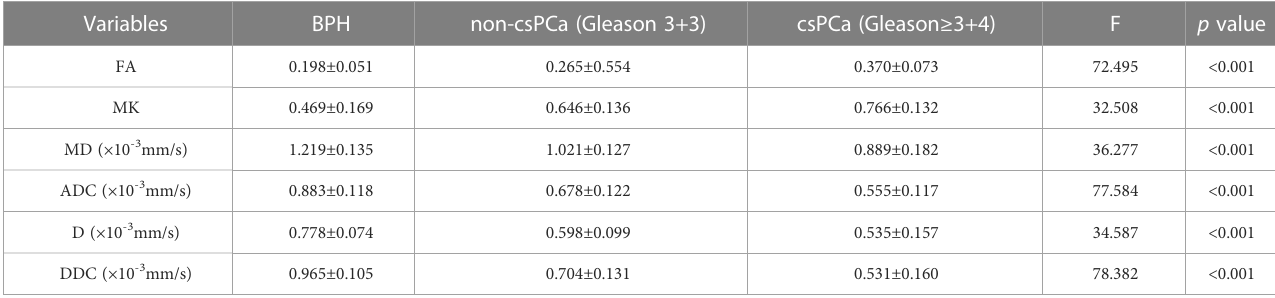
FA, fractional anisotropy; MK, mean kurtosis; MD, mean diffusion; ADC, apparent diffusion coef fi cient; D, pure diffusion coef fi cient; DDC, distributed diffusion coef fi cient; BPH, benign prostatic hyperplasia; csPCa, clinically signi fi cant prostate